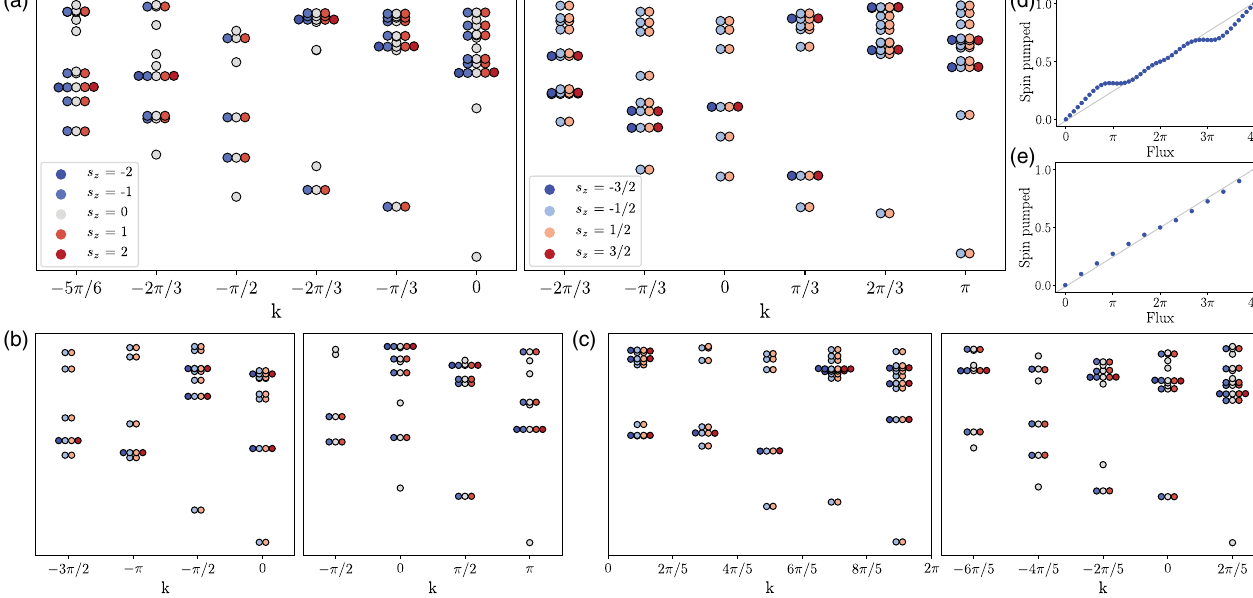
FIG. 13. (a) Momentum- and spin-resolved entanglement spectrum for the YC6 cylinder in the intermediate phase, for the ground state in the k ¼ 0 (left) and k ¼ π (right) sectors; these correspond to the trivial and semion sectors of a CSL, respectively. Insertion of 2 π flux interchanges the two topological sectors, though as discussed in the text there is a subtlety due to working with a fermion model. (b) Momentum- and spin-resolved entanglement spectrum for the YC4 cylinder, with periodic boundaries at U=t ¼ 10 . 2 (left) and with 2 π flux inserted at U=t ¼ 11 . 6 (right), corresponding to the highest chirality in each of the two topological sectors. (c) Entanglement spectrum for YC5 with 2 π flux, U=t ¼ 10 , between two-ring unit cells (left) and between the rings in the unit cell (right), again corresponding to the two topological sectors. (d) Spin pumping as a function of flux insertion in the intermediate phase for YC4 ( U=t ¼ 10 ) and (e) for YC6 ( U=t ¼ 9